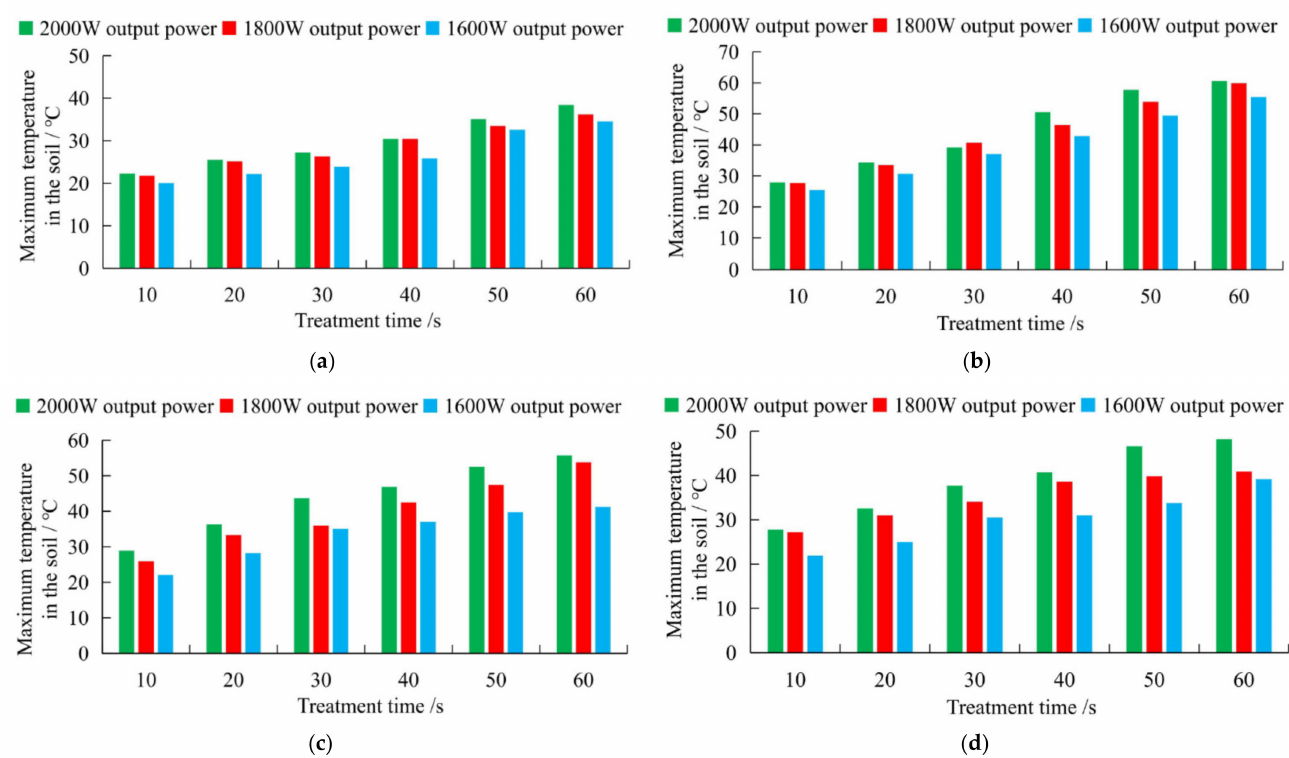
Figure 21. Influence of the microwave output power on the maximum temperature inside the soil: ( a ) 0% soil moisture content; ( b ) 10% soil moisture content; ( c ) 20% soil moisture content; ( d ) 30% soil moisture content.